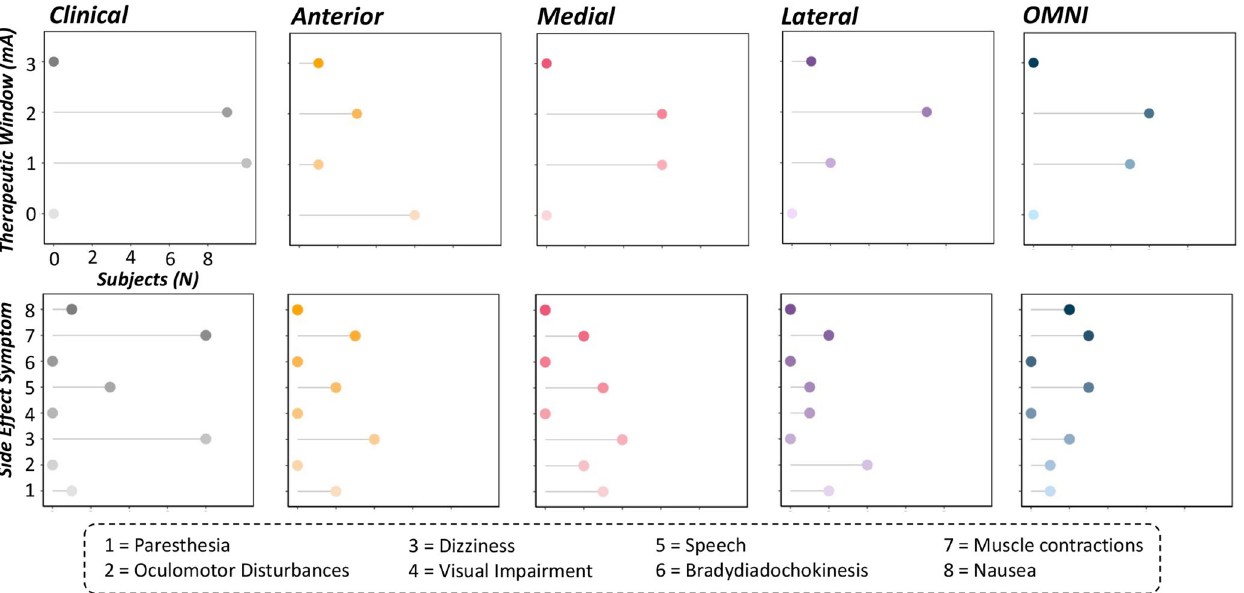
Fig. 4 Observed therapeutic windows and side effects for optimal and non-optimal current administration. Lollipop charts denoting therapeutic windows (i.e., minimal distance in mA from observed clinical effect to observed side effect; y -axis in top panel) observed when undergoing different contact orientations of STN-DBS and reported side effects ( y -axis in bottom panel). The x -axis represents the number of subjects ( N ) and is fi xed for all charts. Reported side effects included paresthesia (1), oculomotor disturbances (2), dizziness (3), visual impairment (4), speech disturbances (5), bradydiadochokinesis (6), muscle contractions (7) and nausea